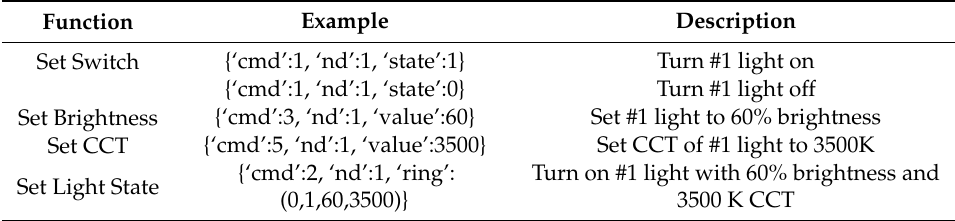
Table 11. Cloud message examples.